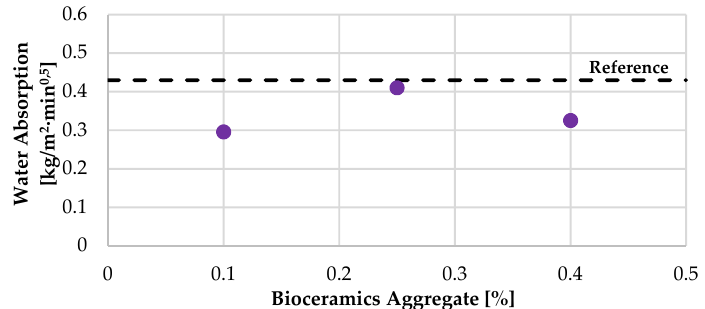
Figure 9. Water absorption by capillarity results for cement mortars.